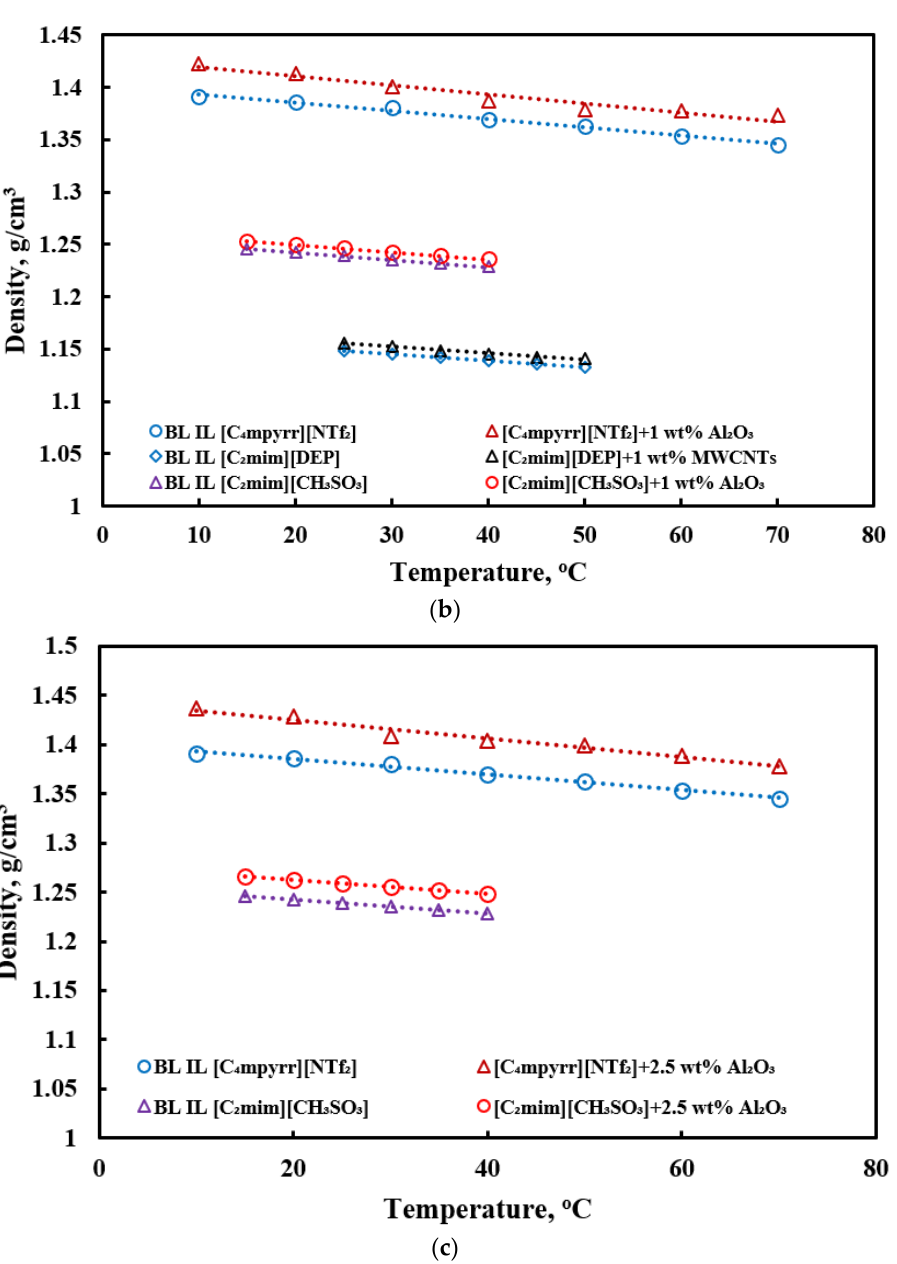
Figure 4. Density of base IL and ILs-based nanofluids as a function of temperature at the different nanoparticle concentrations ( a ) 0.5 wt%, ( b ) 1 wt%, and ( c ) 2.5 wt% [47,84,85]. Reproduced with permission from [Xie, Chereches, and Paul],